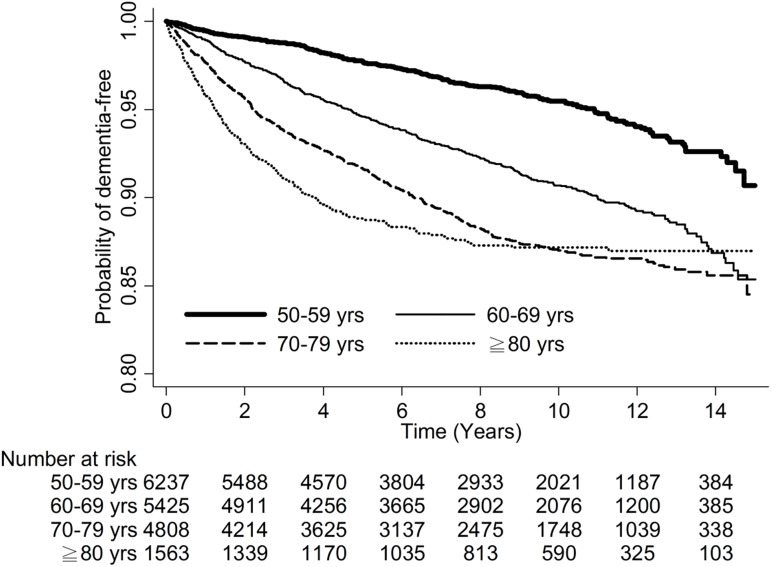
Kaplan-Meier curve shows the probability of being dementia-free after hospital discharge for patients admitted to the intensive care unit and mechanically ventilated.